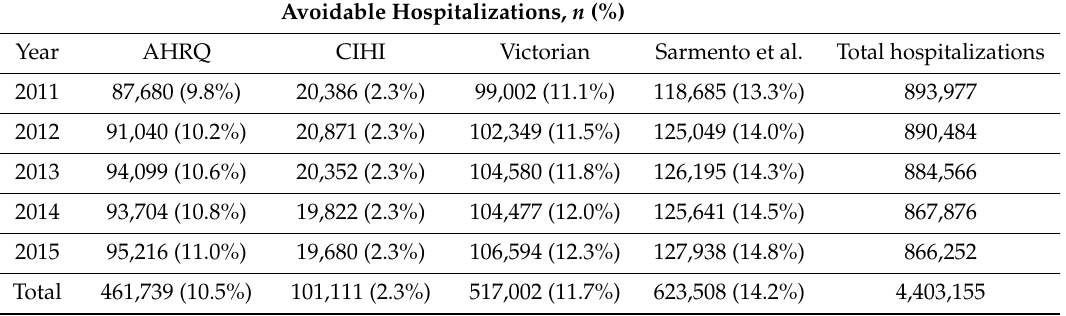
Table 2. Number of Hospitalizations Per Year and Respective Proportion of Avoidable Hospitalizations by Four Distinct